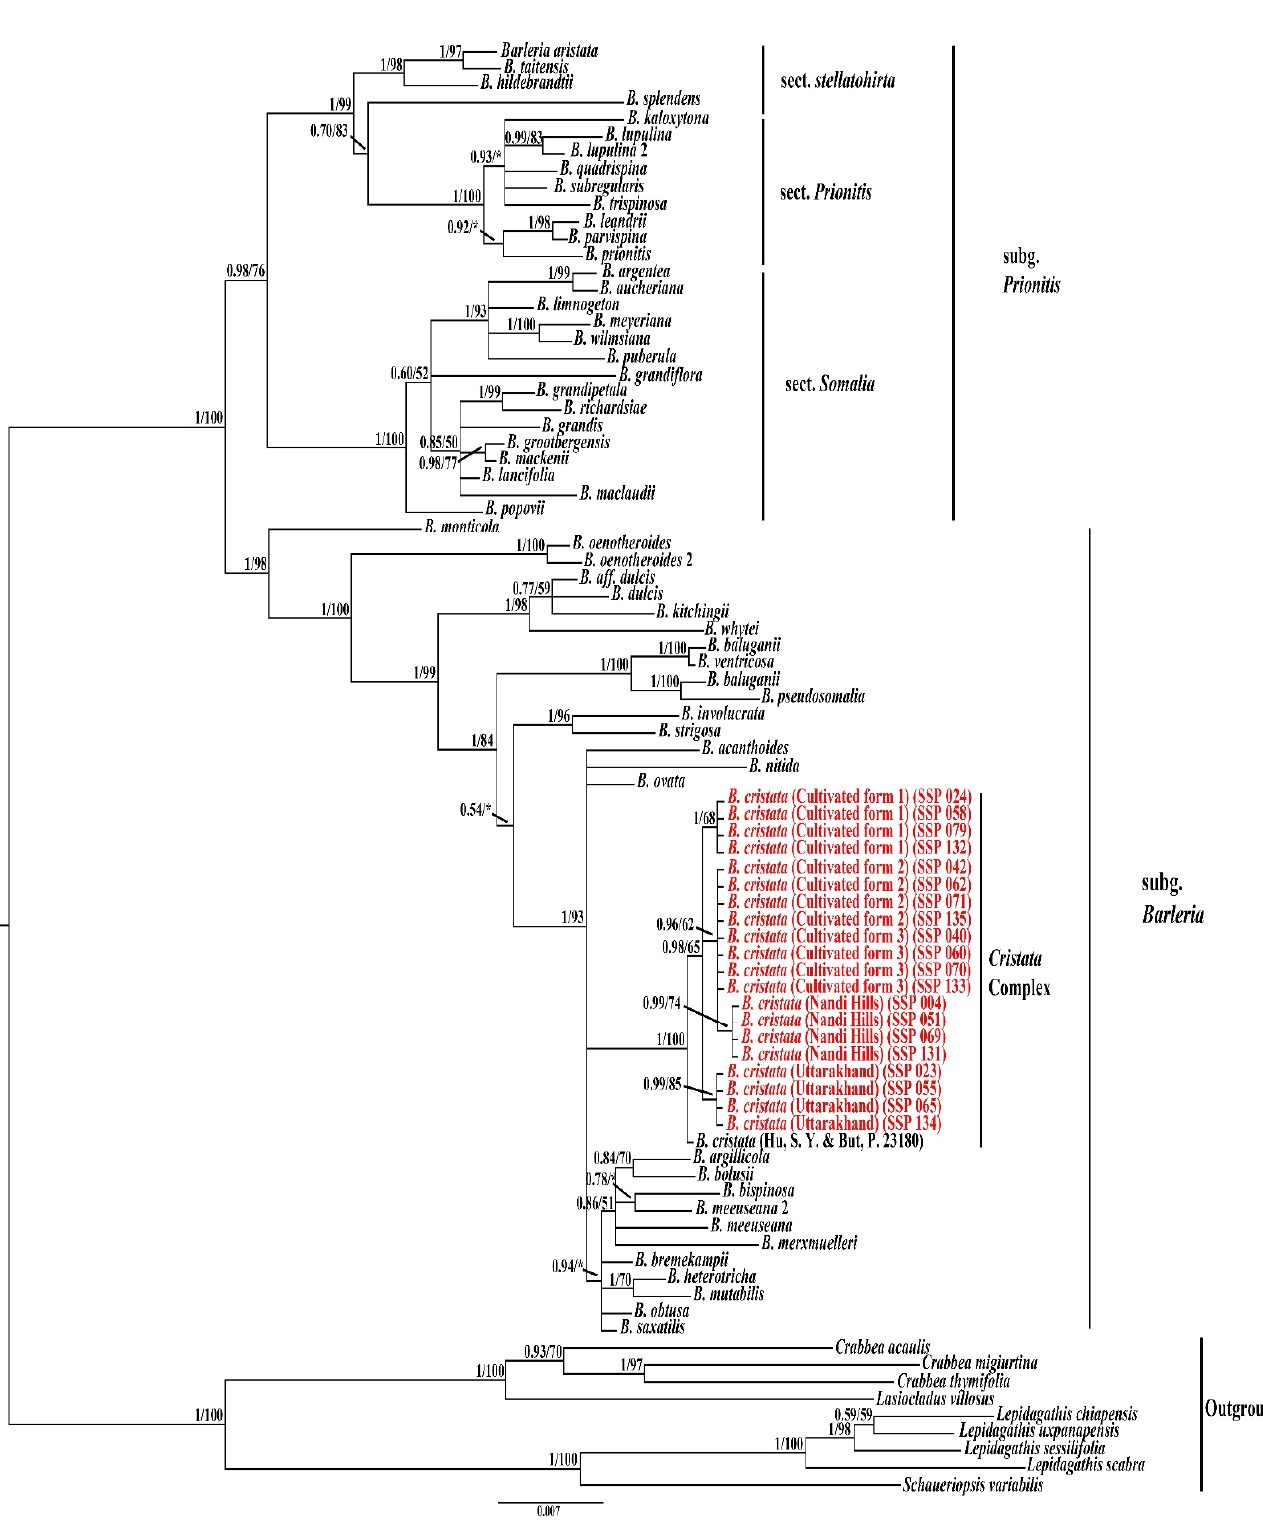
Figure 5. 50% Majority-rule consensus Bayesian phylogenetic tree based on cpDNA data ( ndh F- trn L (UAG) + trn S-G). Bayesian posterior probability values and maximum likelihood bootstrap values (BPP/ML BS) are provided above branches. Asterisk (*) indicates ML BS values < 50%. The taxa sampled in this study are in red color and their voucher details in parentheses.